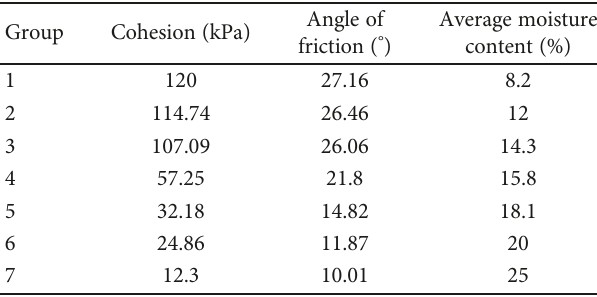
Figure 10: Medium-size direct shear test on remolded samples; shear stress-displacement curves and strength parameters of all seven groups. Table 1: Direct shear tests parameters of soil with particle size less than 2